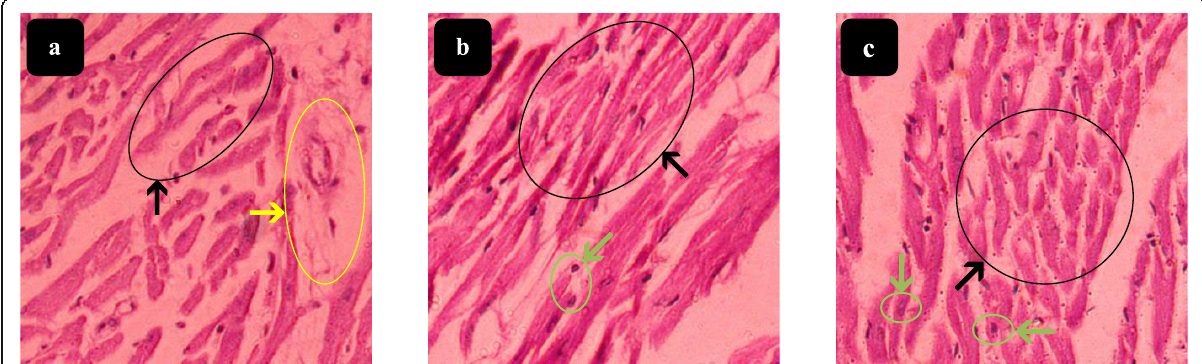
Fig. 4 Cardiac histology of (200mg GE+ISO) treated rat (Group 4): ( a ) sacrificed on 31st day revealed highly pronounced edema with inflammation and nuclei aggregation (pointed with yellow arrow) in cardiomyocytes and distorted myofibrils (pointed with black arrow), ( b ) sacrificed on 46th day shows less prominent cardiac necrosis with less pronounced distortion of myofibril structure (pointed with black arrow) and less aggregation of nuclei (pointed with green arrow), (c) sacrificed on 61st day showed approximately similar looking cardiac histoarchitecture as normal control rats with normal structure of myofibrils (pointed with black arrow) and regular and central distribution of nuclei (pointed with green arrow) but some portions were still damaged